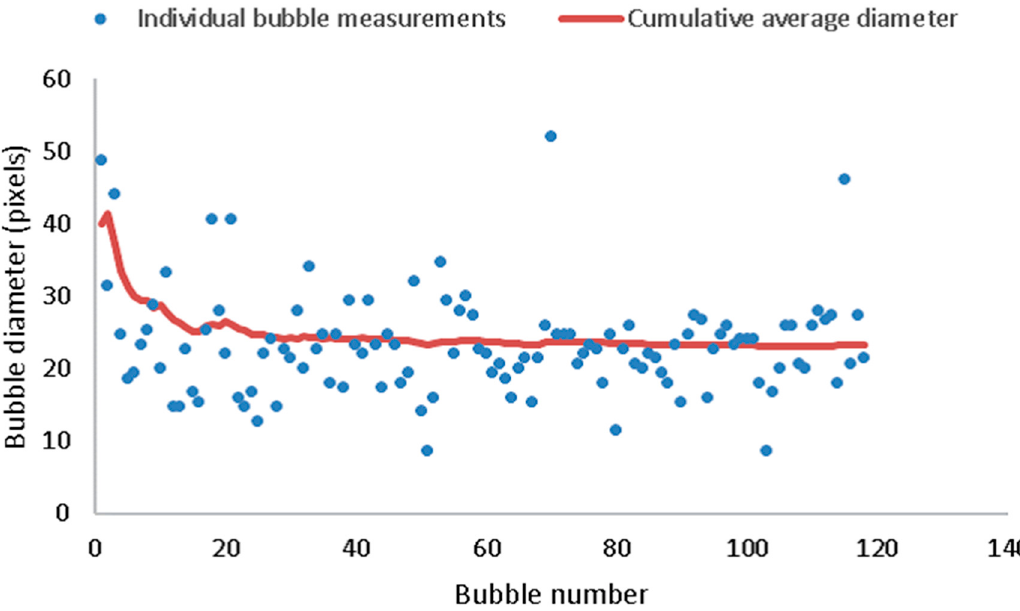
Figure 3. The bubble diameter of 118 bubbles along with the cumulative average, indicating that the minimum sample size that can be used is 50